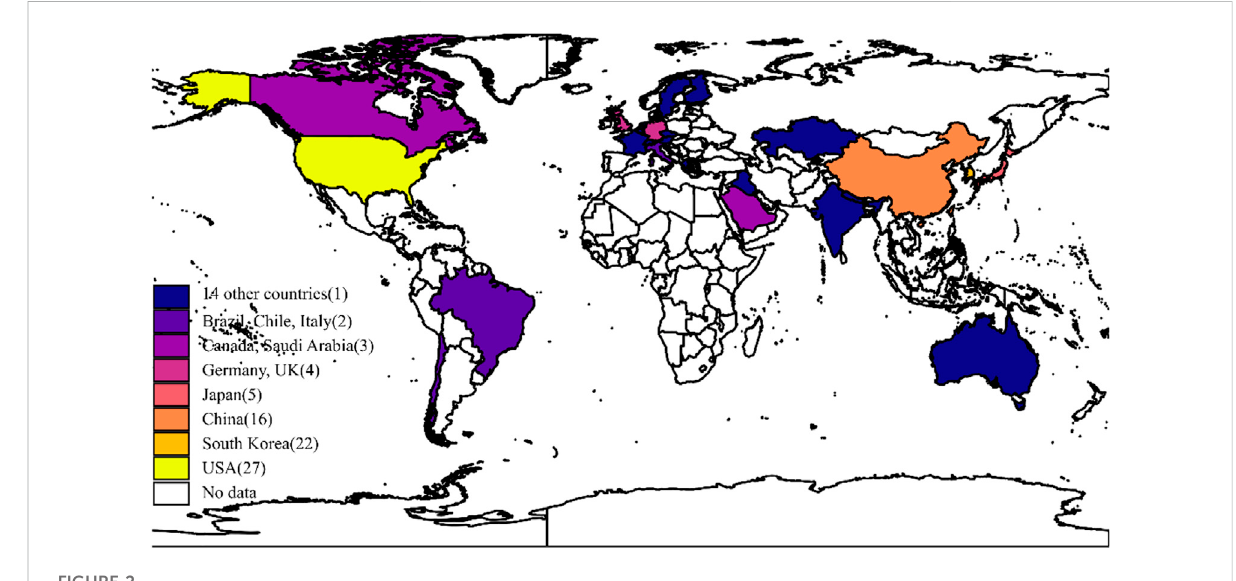
FIGURE 2 Number of publications by country or region.